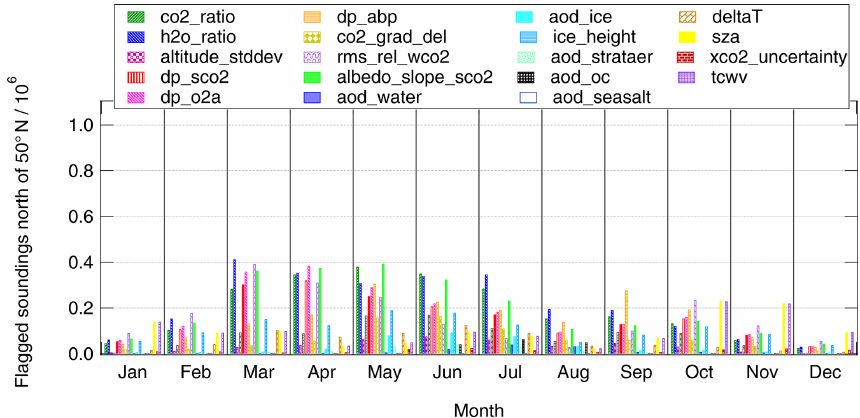
Figure 4. Total number of land soundings north of 50 ◦ N flagged bad by boreal-quality filters in each